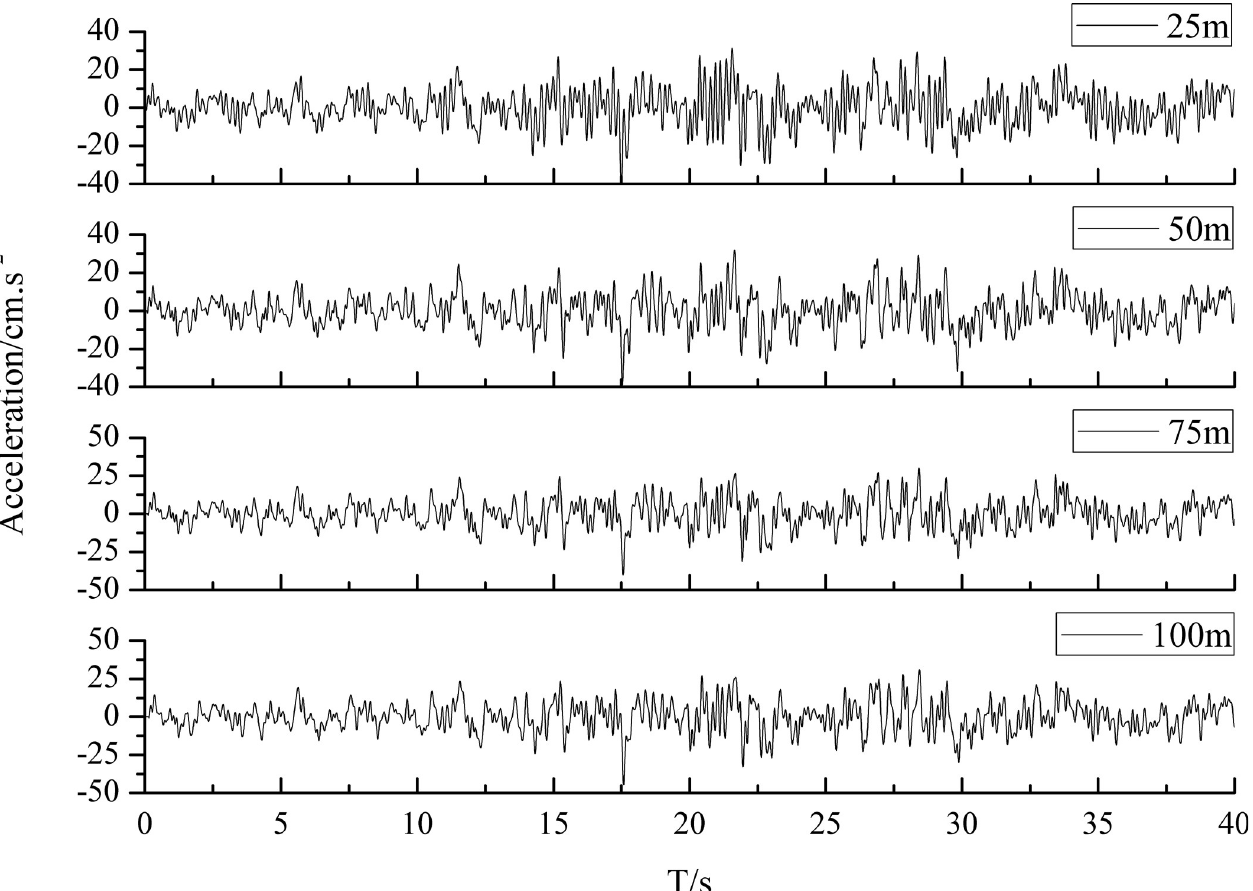
Fig 4. Ground motion acceleration time history of the sites with different overburden